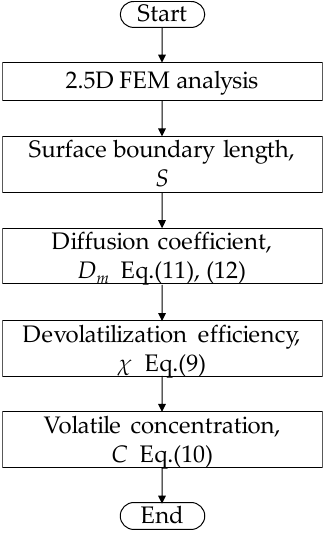
Figure 3. Flow chart for calculating the volatile concentration.